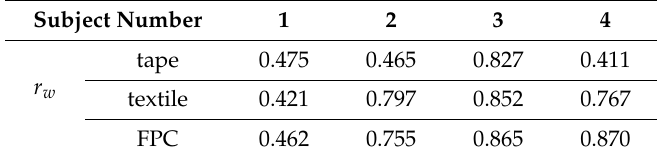
Table 10. Correlation coefficient of waveform of ECG signals measured in the lying supine